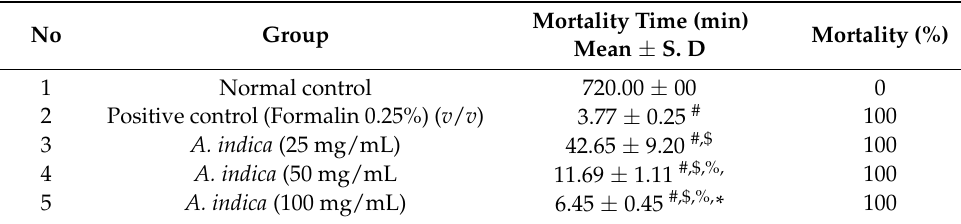
Table 2. Mortality time of parasitic leeches treated with different concentrations of aqueous extract of